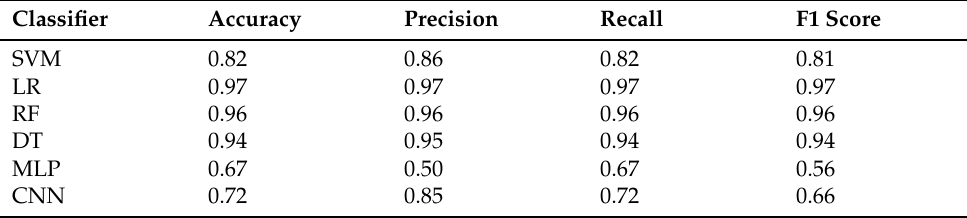
Table 6. Results of machine learning and deep learning classifiers with 90–10 train–test split.